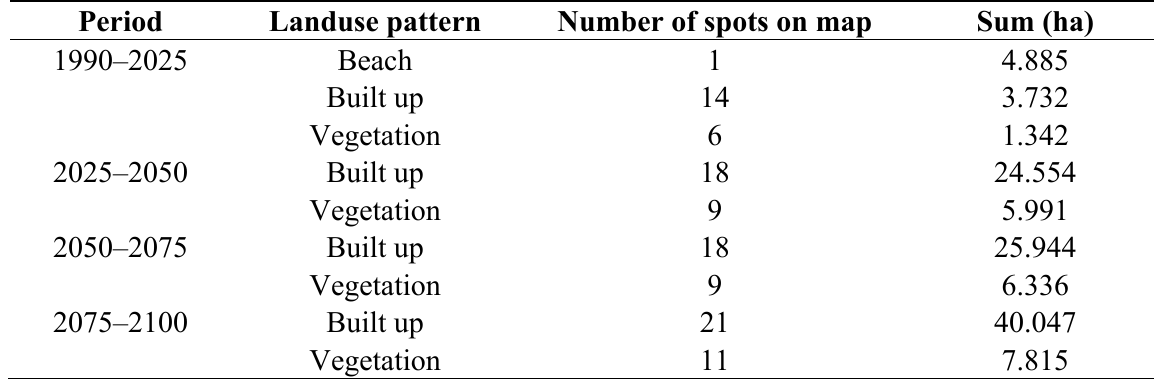
Table 4. Estimated built up area and vegetation to be lost.